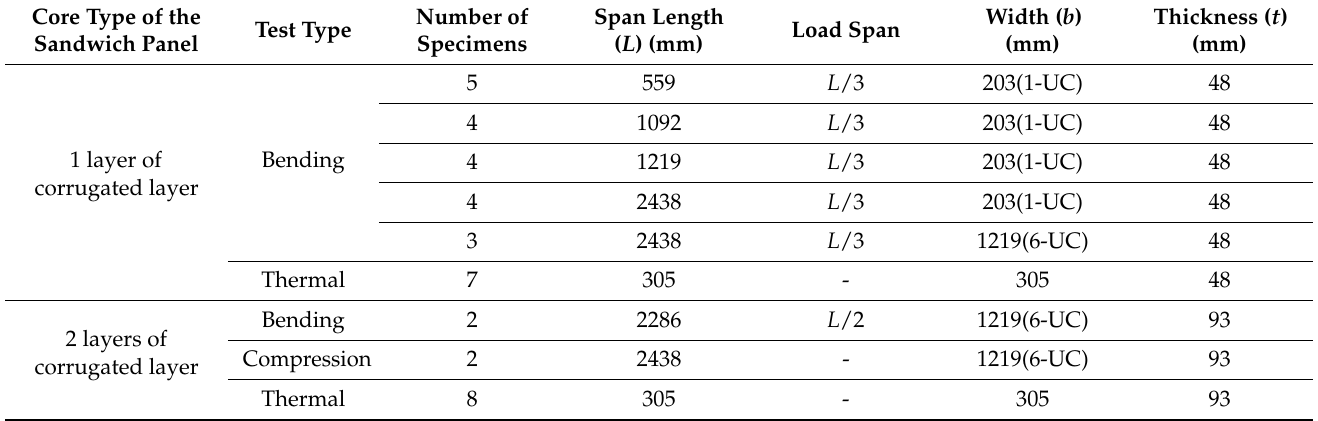
Table 1. Summary of all experimental specimens subjected to different